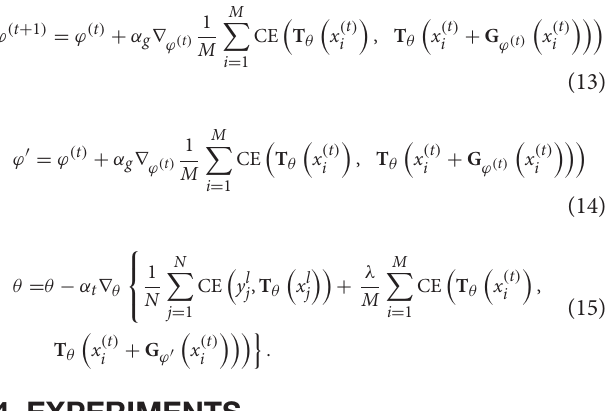
Frontiers in Neurorobotics |